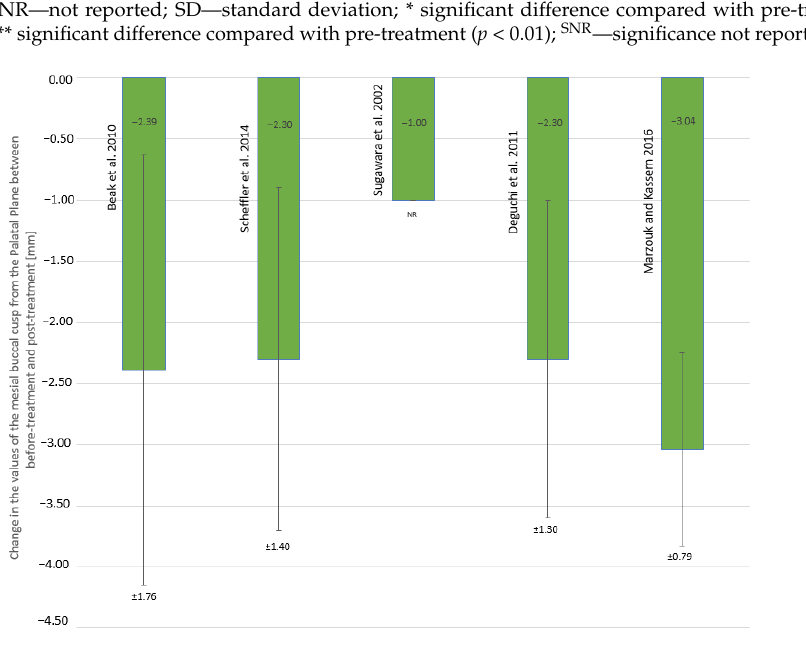
Figure 2. Change in the values of the distance of the mesial buccal cusp of the first upper molar from the palatal plane (mm); NR—not reported.